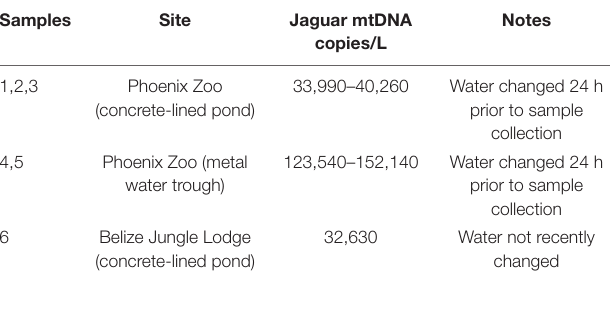
TABLE 3 | Jaguar mtDNA concentration for five samples collected from drinking water sources provided to captive animals.